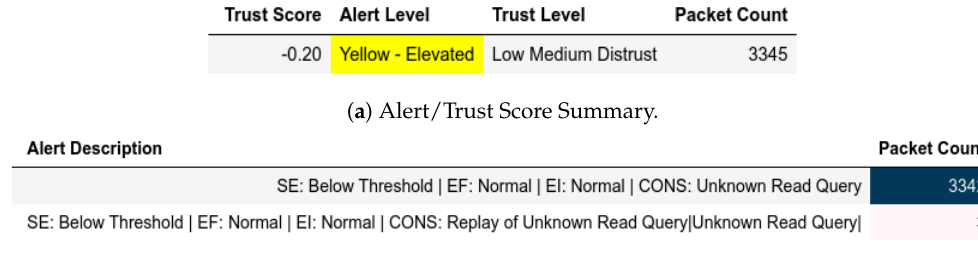
Figure 12. Server: EPM dataset internal test- H (cid:48) in command-and-control attack capture.